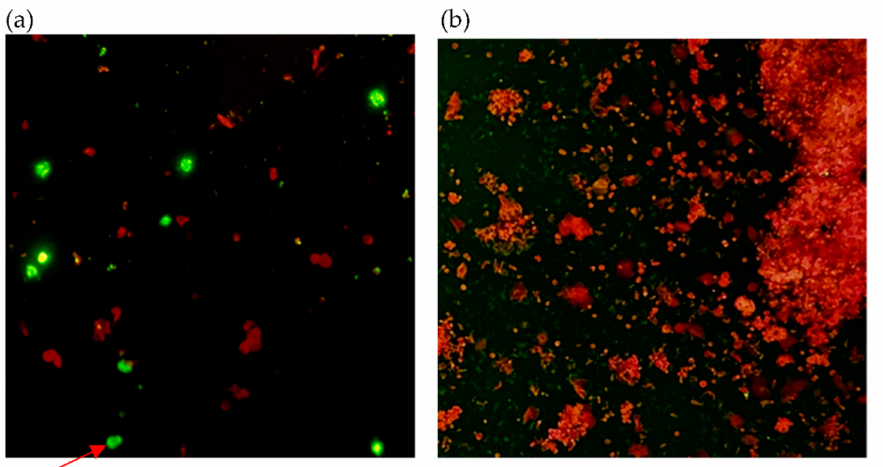
Figure 2. Smears of cells from clinical NPS from COVID-19 patients stained with primary antibody against SARS-CoV-2 N protein (original magnification × 200). ( a ) Smear of cells from COVID-19 patients with positive results. ( b ) Smear of cells from non-infected individuals with negative results. Red arrow indicates positive